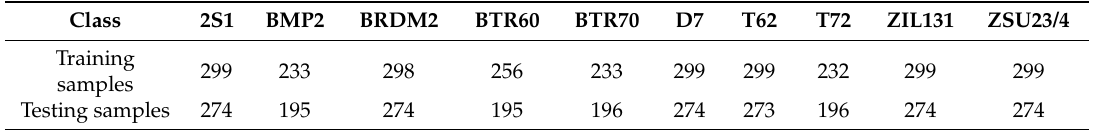
Figure 5. Optical images and SAR images of targets under SOC. Table 1. Dataset of Experiment under SOC.